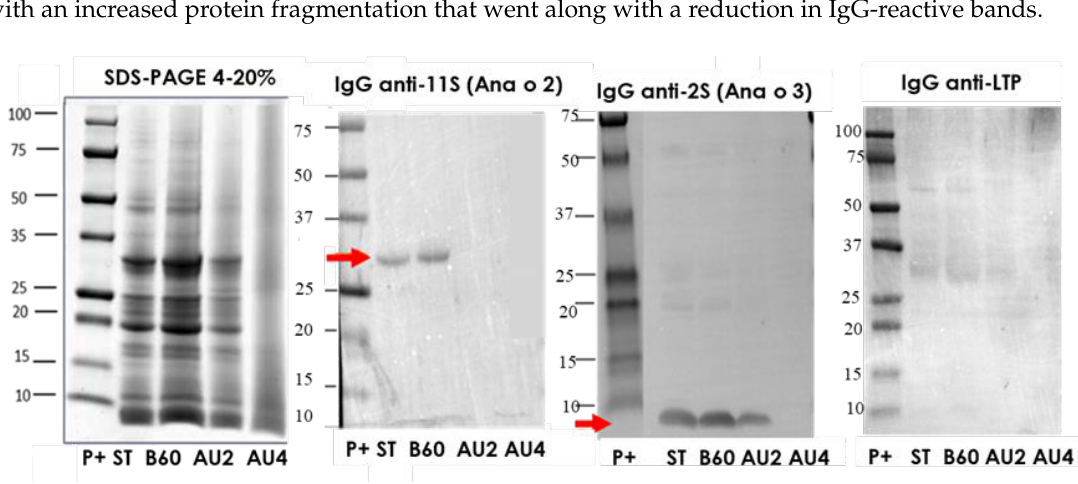
Figure 1. SDS-PAGE and IgG anti-11S, anti-2S, and anti-LTP immunoblots analysis of control (ST), boiled for 60 min (B60) and autoclaved at 121 °C for 30 min (AU2) and at 138 °C for 30 min (AU4) cashew samples. Molecular weight marker was Precision Plus (P+).